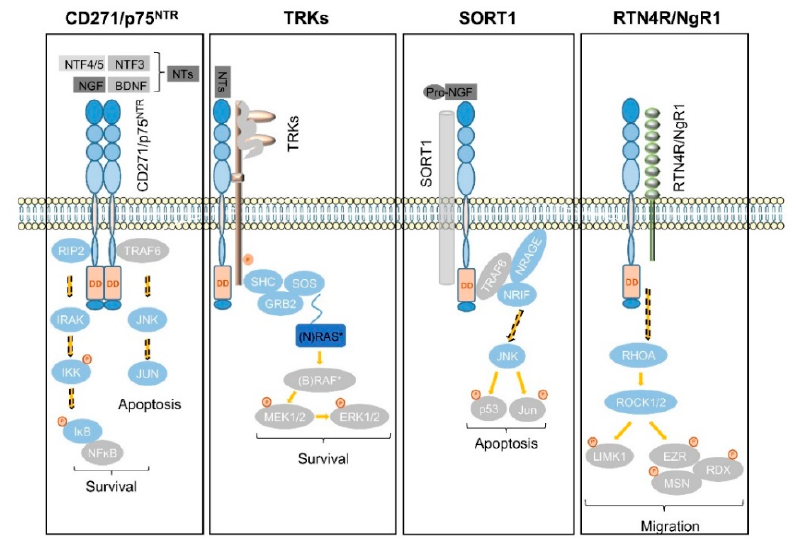
Figure 4. Signaling mechanisms of CD271. First panel: in the absence or low expression of co-receptors, CD271 form homotetramers (homodimers are shown) and controls either cell survival via a RIP2-mediated activation of NFkB and downstream pro-survival genes or apoptosis via TRAF6. The latter competes with RIP2 for binding to CD271 and activates JNK (c-Jun N-terminal kinases) / JUN signaling. Second panel: The activation of the typical mitogen-activated protein kinase pathway (MAPK) is triggered by binding of neurotrophins to the complex of CD271 and tropomyosin-related kinases (TRKs), leading to signaling processes mediated by ERK1 / 2 (extracellular-regulated kinases) or PI3K (phosphatidylinositol 3-kinases) promoting proliferation and cell survival. Third panel: the aggregation of CD271 with sortilin triggers apoptosis in response to neurotrophin precursors, e.g., pro-NGF. Apoptosis is induced via the recruitment of TRAF6 (tnf-receptor associated factor 6), NRAGE / MAGED1 and NRIF to the dead domain (DD) of CD271 via c-jun n-terminal-kinase (JNK) or via activation of NFkB. Fourth panel: CD271 triggers the activation of RHOA (RAS-homolog family member A) and RHO-kinases which in turn activate LIM-kinase (LIMK1) and ERM proteins (EZR; ezrin, RDX, radixin and MSN; moesin) to control cell migration in conjunction with nogo receptor / RTN4R (reticulon 4 receptor). Signaling via CD271 (p75 NTR ) homodimers mediates the activation of NF ĸ B signaling, driving